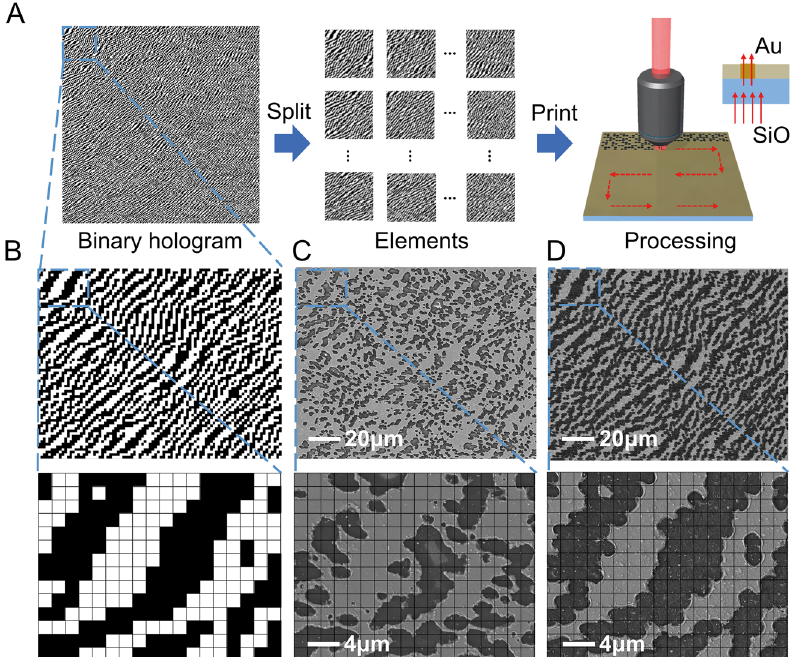
Figure 4: Fabrication of binary holograms through the splitting-stitching method using femtosecond laser holographic patterning. (A) Flow diagram of the splitting-stitching method. (B) Local magnification of the binary hologram in (A). (C) SEM image of the fabricated